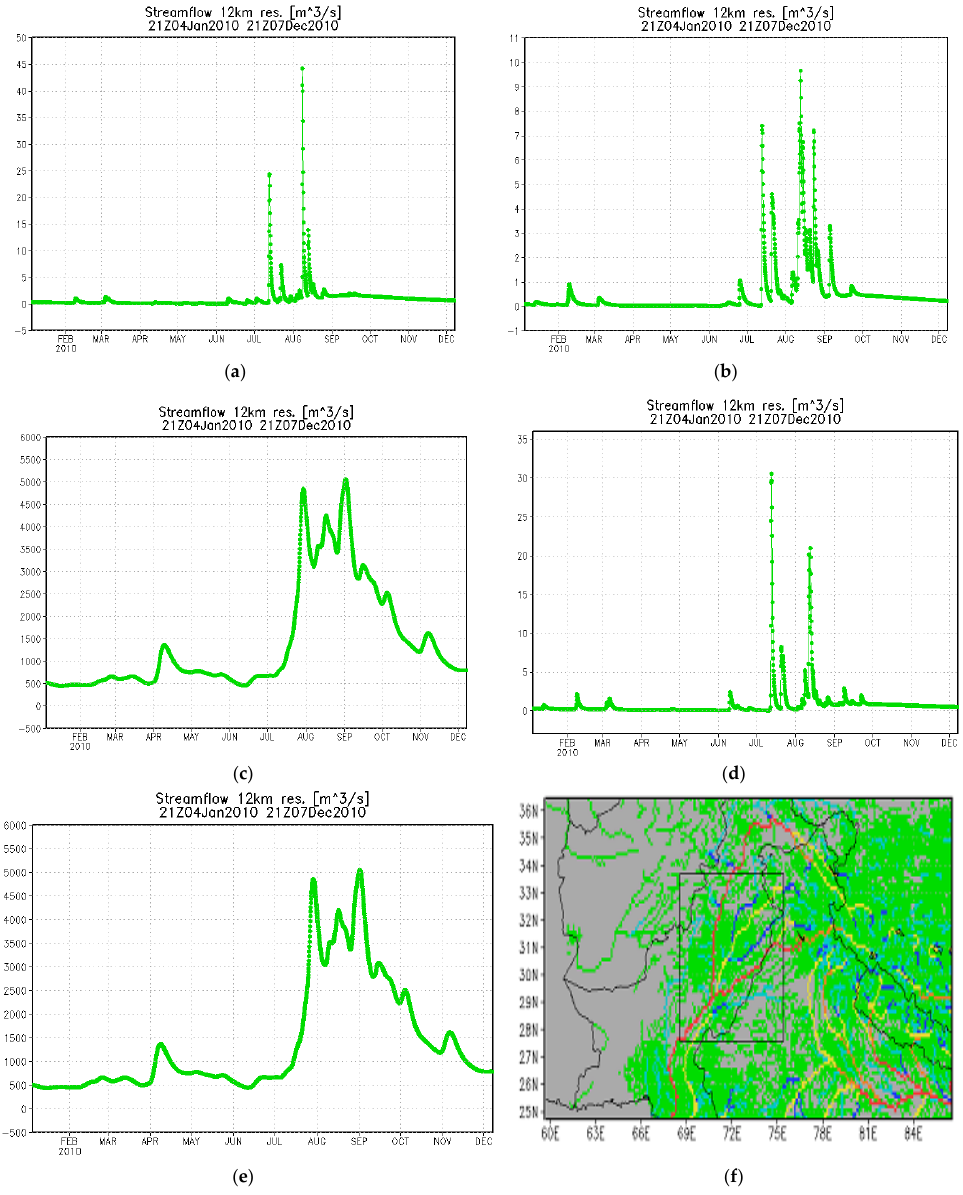
Figure 6. The captured stream flow events with temporal resolution (3 hourly) at relatively high spatial (~12 km) resolution over five weather stations ( a – e ) highlight the flood stream flow at time series (21Z04Jan2010 to 21Z07Dec2010), whereas, ( a ) represents St. 1, and ( d ) presents St. 4, showing the central area of the plain, while ( b ) presents St. 2 in the north of the plain, ( c ) represents St. 3, and ( e ) represents St. 5 in the south of the plain, respectively, which shows a maximum water flow above the threshold in the south of the region (the flood event happened in Punjab). ( f ) Indicates the maximum water flow in the Indus Basin.